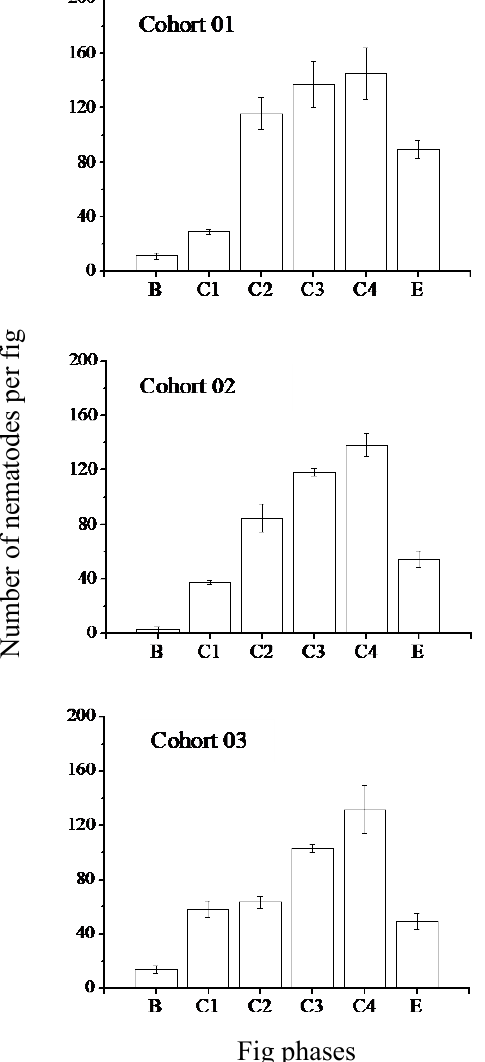
Figure 4. Nematode population sizes during the development of female figs of Ficus hispida . All nematode species and stages combined (means ± SE, N = 5 to 8 figs for every phase). Pollinator fig wasp vectors of the nematodes enter during the B phase. Phases C1–C3 cover the early, middle and late periods when seeds are developing. Female figs have no D phase. Phase C4 covers the equivalent period when the seeds mature but before the figs soften, change colour, and become attractive to vertebrates (E phase).